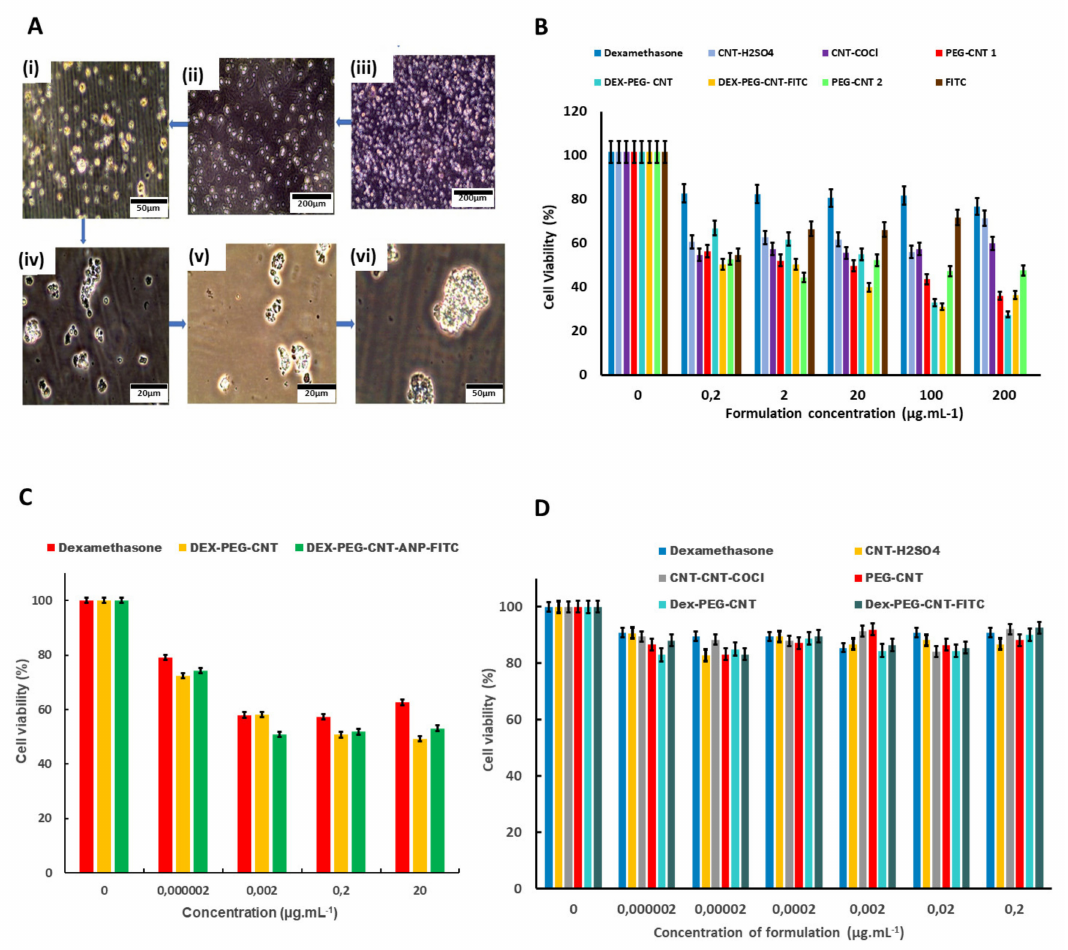
Figure 9. Cytotoxicity of the functionalized CNTs in PC-12 cells. PC-12 cells under inverted light microscope at di ff erent magnifications ( A (i–vi)). Cell viability of PC-12 incubated with functionalized CNTsatdi ff erentconcentrationsto200 µ g · mL − 1 ( B